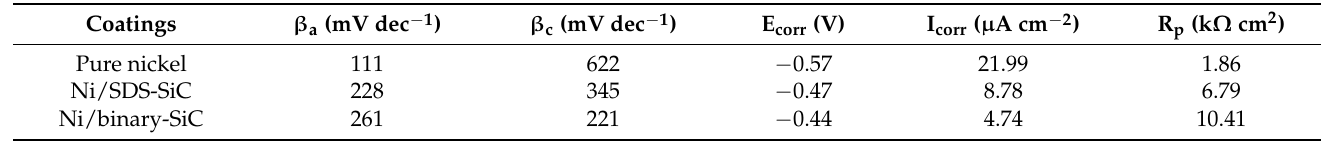
Table 2. Electrochemical parameters of the pure nickel, Ni/SDS-SiC and Ni/binary-SiC coatings prepared at the current density of 2.0 A dm − 2 .